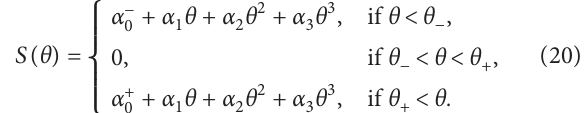
Figure 3: Bifurcation diagrams: (a) α � 2, α � 0. For small values of | α (b) α 1 2